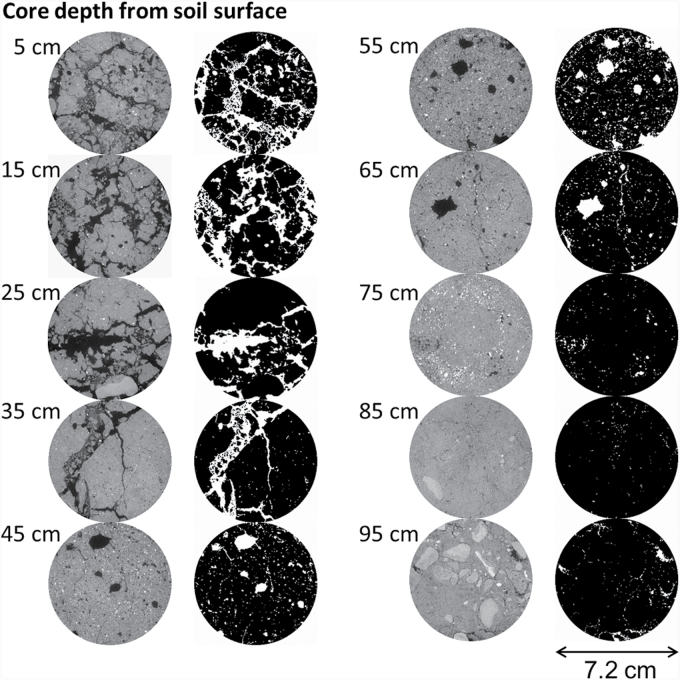
Examples of the horizontal greyscale image slices (left column) and the corresponding segmented binary slices (right column) of a soil core (sample #140) at 5 cm incremental depths from the soil surface.